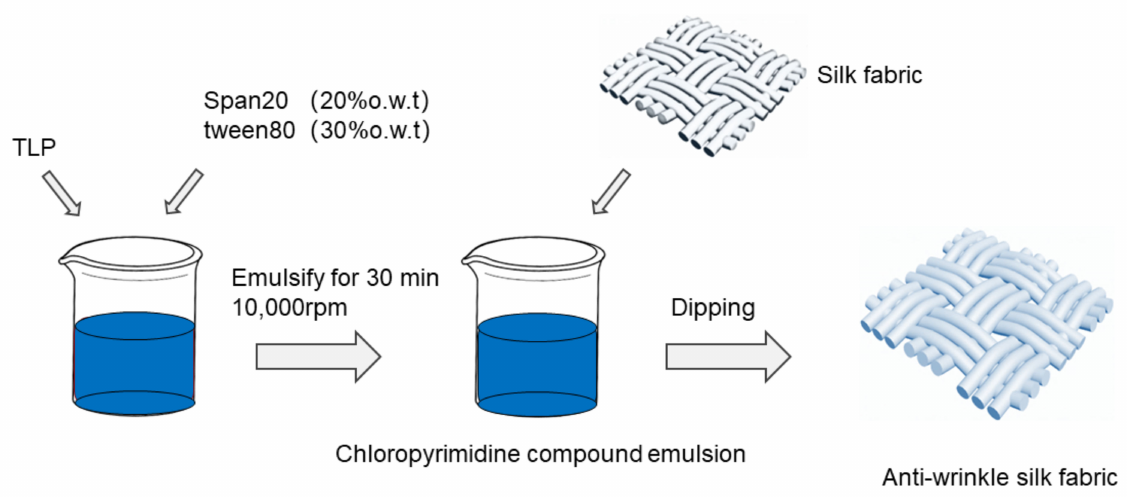
Figure 1. Schematic of the preparation process of anti-wrinkle silk